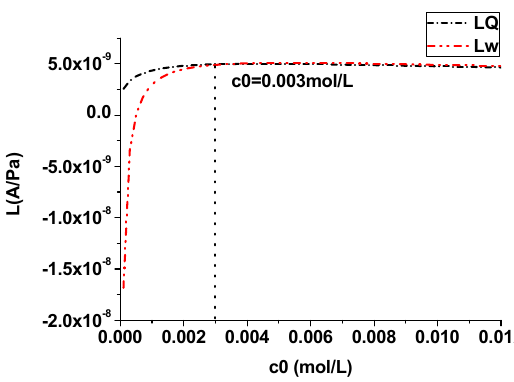
Figure 16. Comparison of the simulation results between the Pride theory and the proposed theory (experimental condition, including the large-Debye-length case).